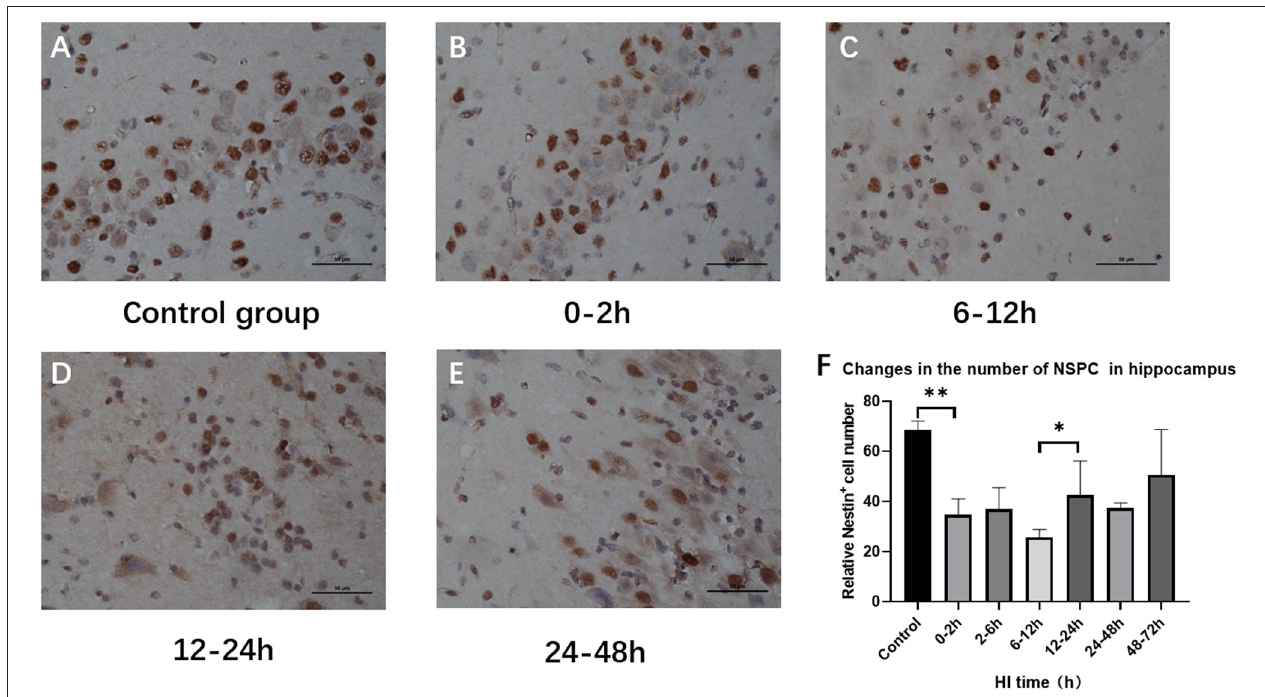
FIGURE 4 | Variations in the number of hippocampal NSPCs after HI injury ( × 400). (A) Nestin immunohistochemical staining in the control group. (B–E) Nestin immunohistochemical staining at 0–2 h, 6–12 h, 12–24 h, and 24–48 h after HI. The number of Nestin-positive cells in the hippocampus decreases first and then increases. (F) The number of Nestin-positive cells decreases at 0–2 h after HI injury compared with the control group, and it significantly increases in the 12–24 h group compared with the 6–12 h group. ** P < 0.01, * P < 0.05, and data are expressed as mean ± standard deviation.